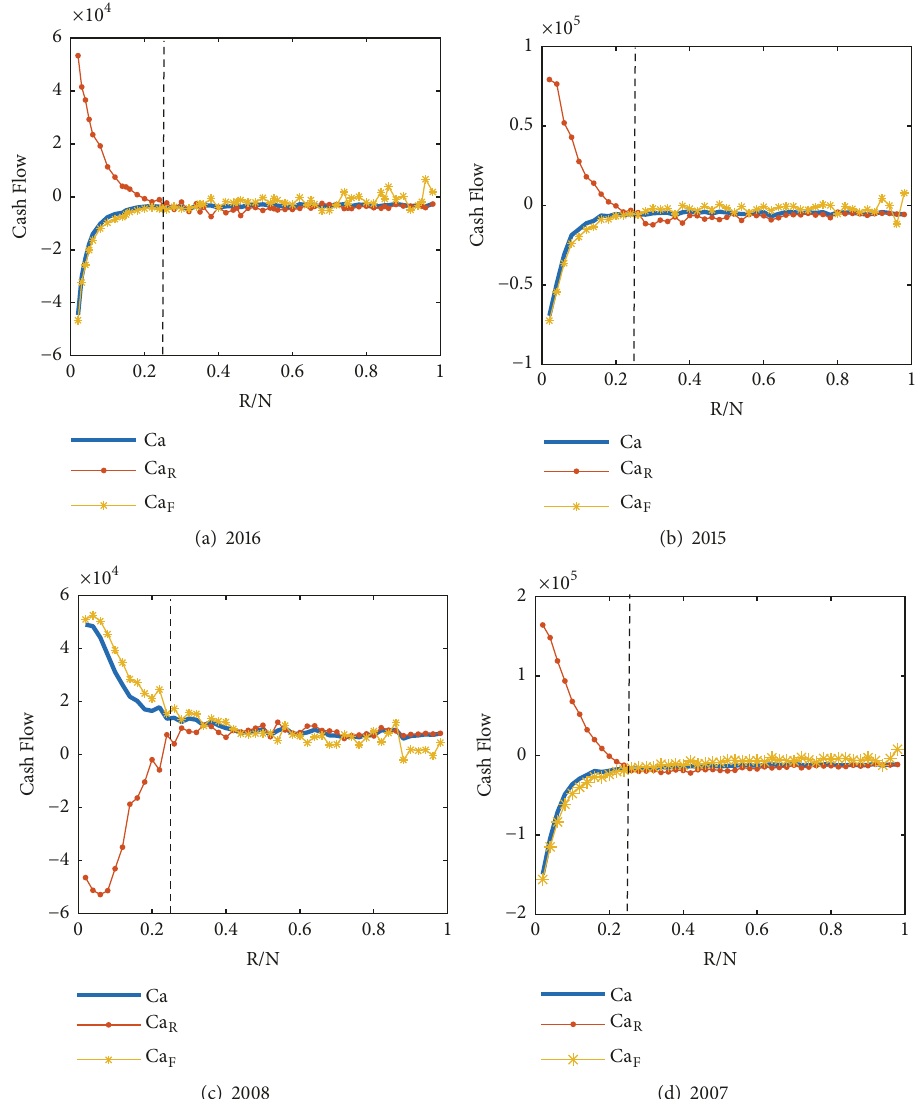
Figure 7: Changes in average cash flows with an increase of 𝑅/𝑁 . The four panels refer to China’s stock market in four different years, and each compares the average cash flows of contrarians and